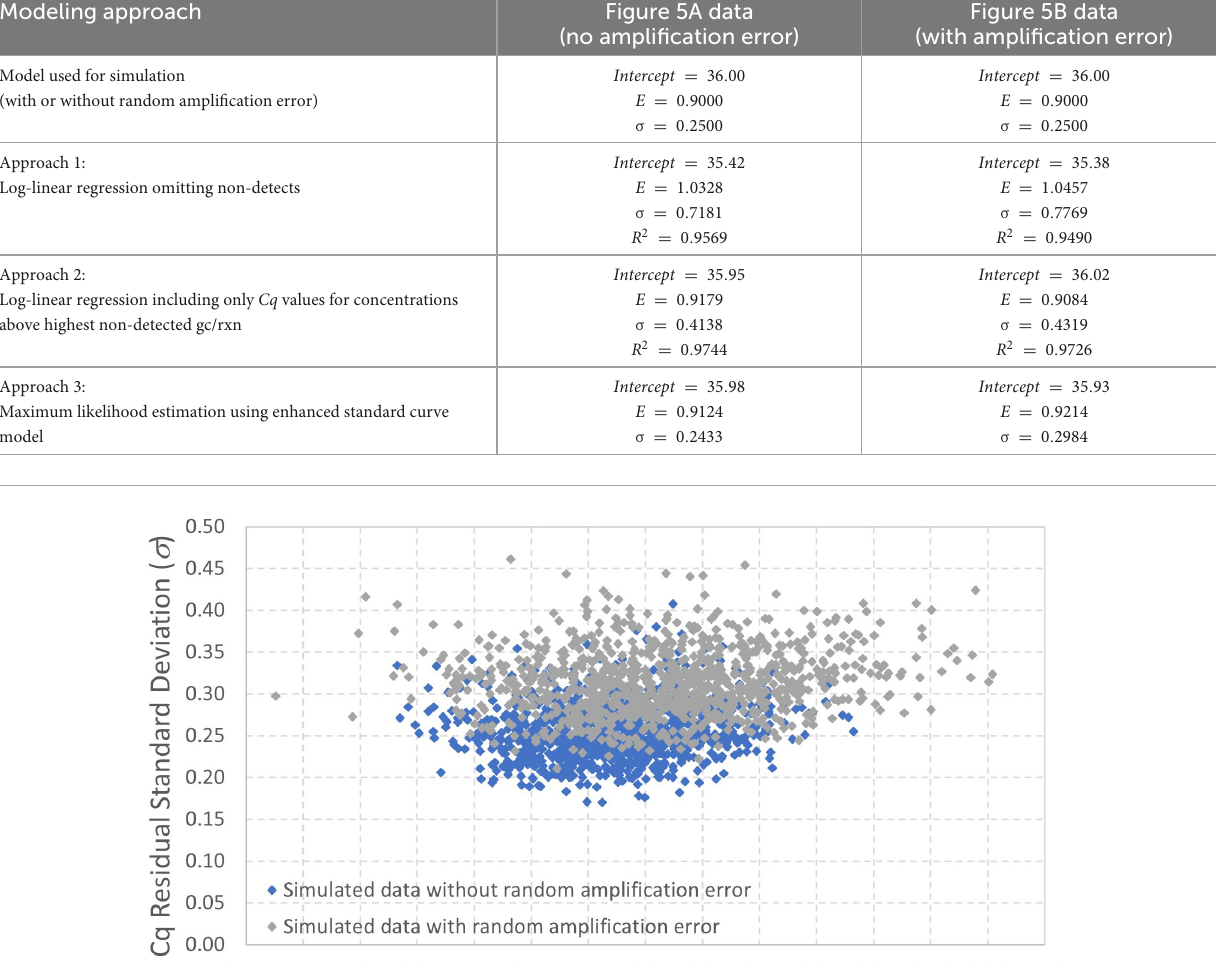
Figure 5B data (no amplification error) (with amplification error)